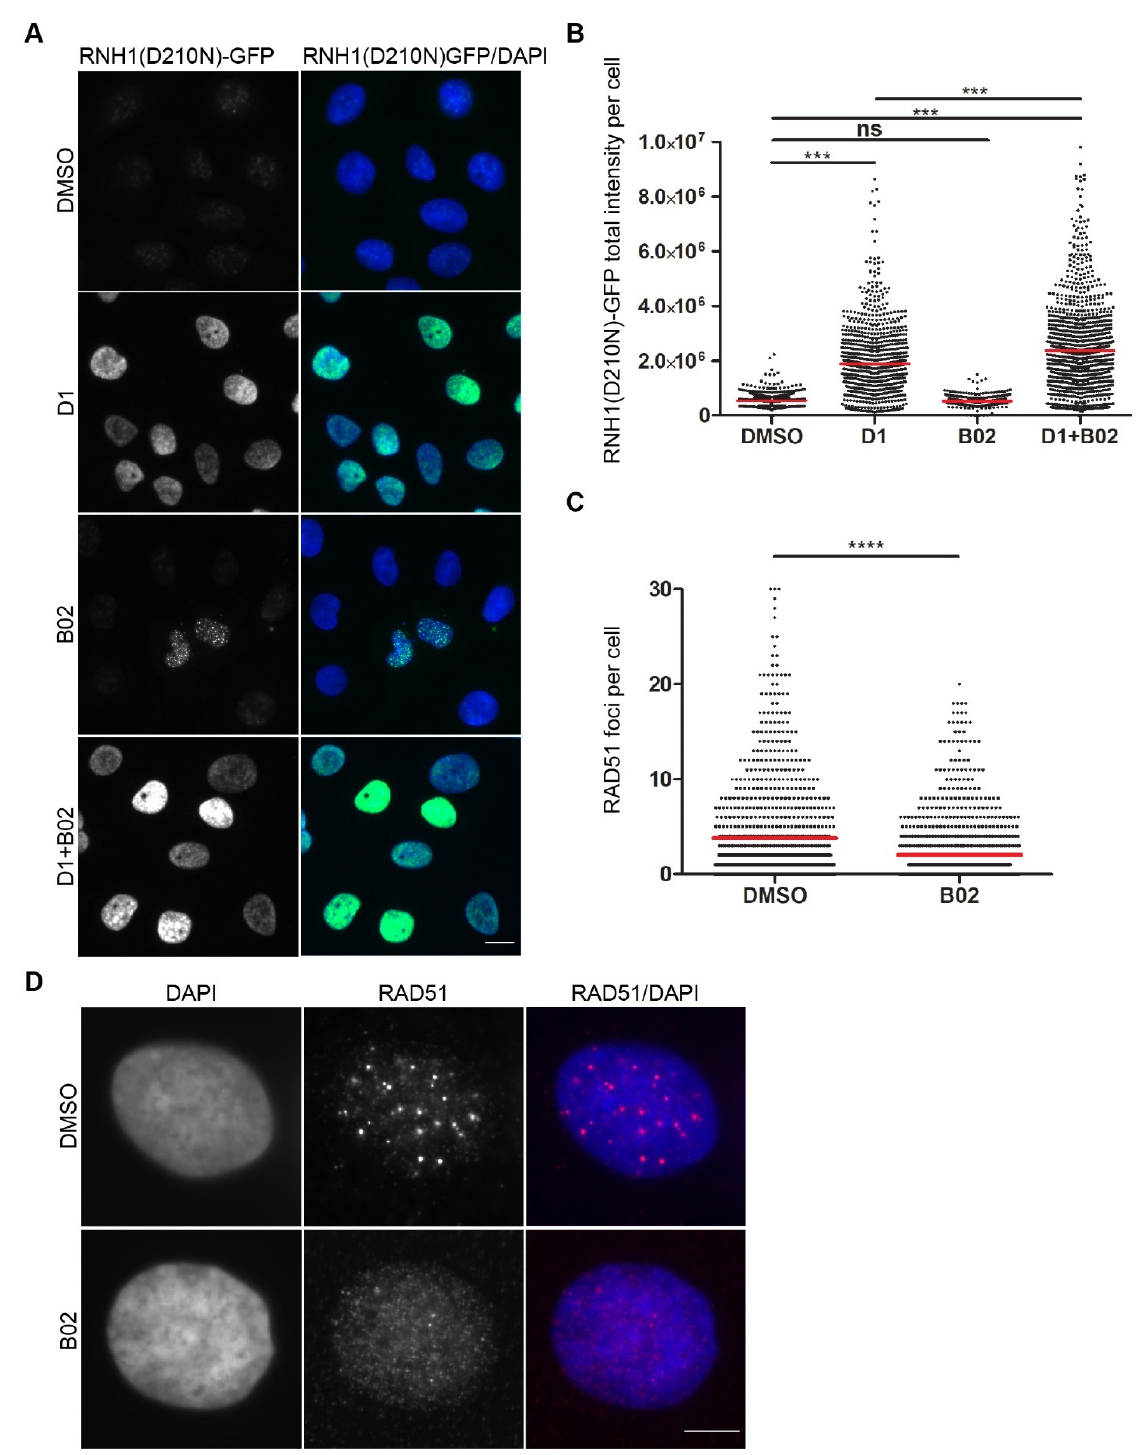
Figure 1. RAD51 is not required for R-loop formation induced by the inhibition of spliceosome assembly. ( A , B ) U-2-OS T-REx (RNH1(D210N)-GFP) cells were treated with doxycycline (1 ng/mL) for 24 h. B02, a RAD51 inhibitor, (20 µ M)